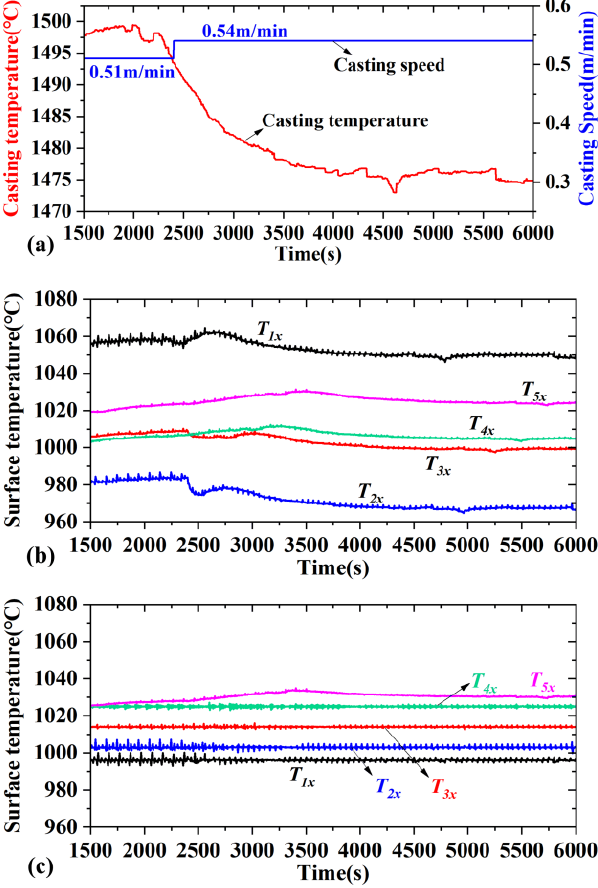
Figure 13. Surface center temperatures at the end of different zones: ( a ) casting conditions; ( b ) surface temperatures before optimization; ( c ) surface temperatures after